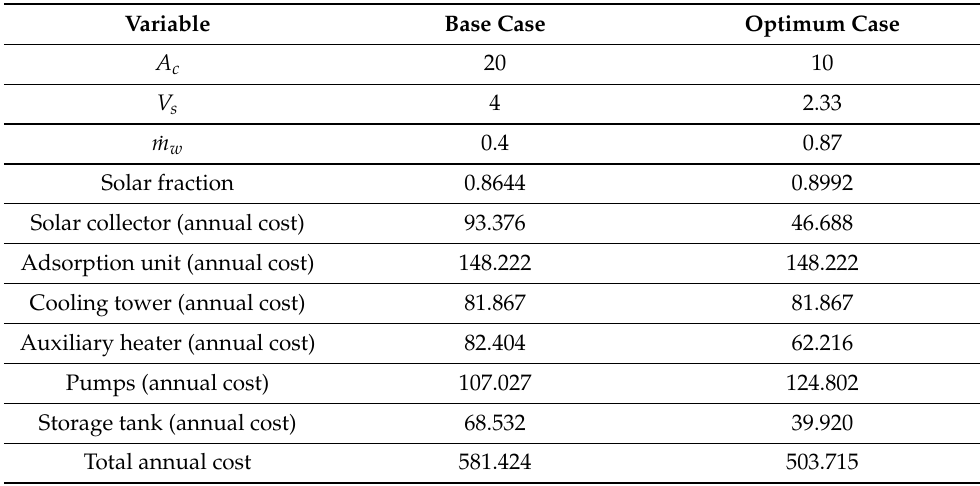
Table 6. The value of the main variables in base and optimum